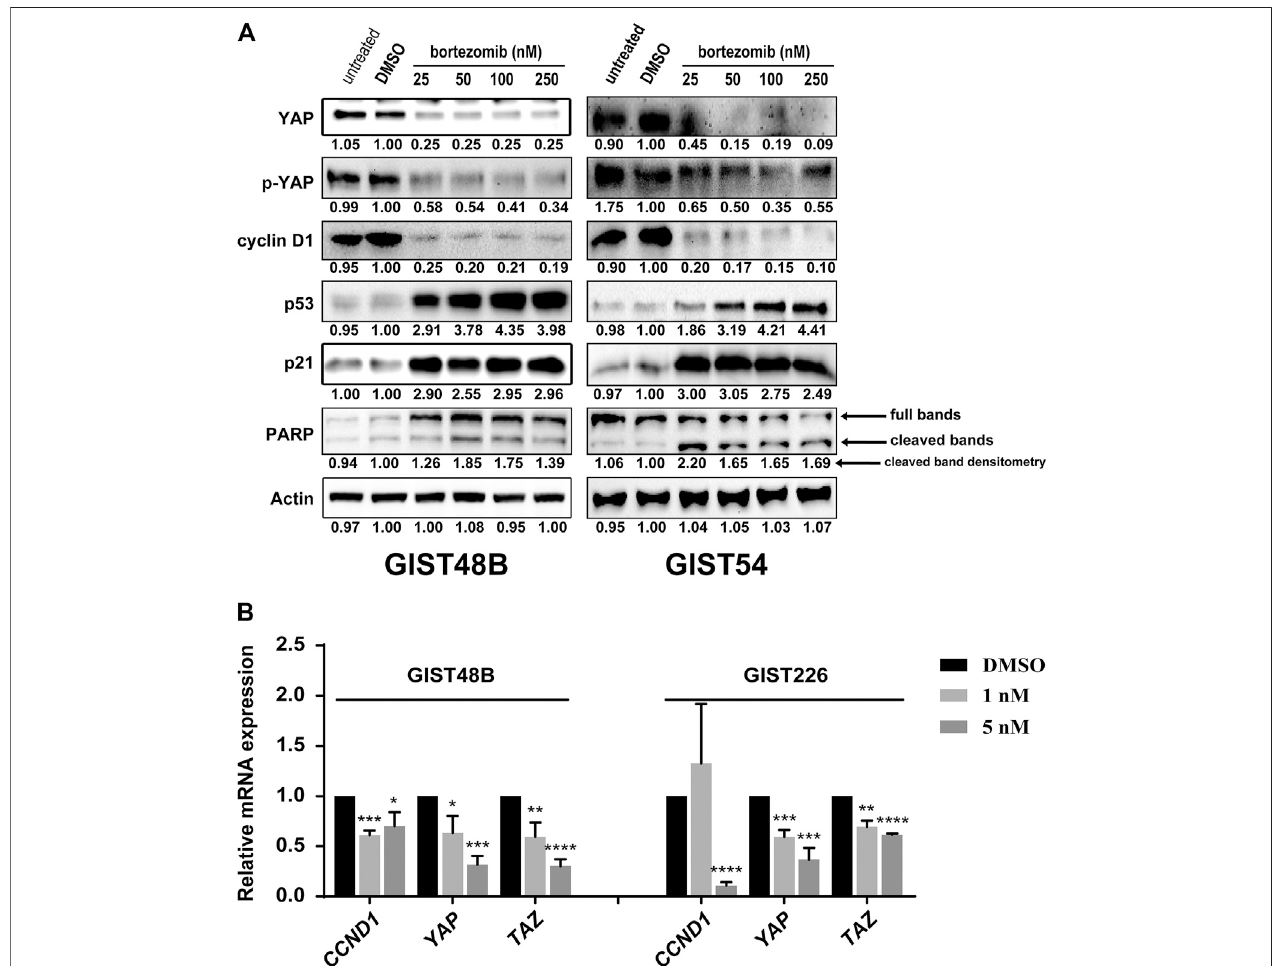
FIGURE 2 | (A) Immunoblotting evaluated expression of cyclin D1, YAP, p-YAP, p53, p21, and pro-apoptotic marker PARP in KIT-independent GIST cell lines (GIST48B and GIST54) after treatment with bortezomib for 72 h. Actin stain is a loading control. Linear capture quantitation of immunoblotting chemiluminescence signals,usinganImageQuantLAS4000.IntensityvaluesarestandardizedtotheDMSOcontrol. (B) QuantitativeRT-PCRevaluationsof CCND1 , YAP ,and TAZ transcript expression in GIST48B and GIST226 after treatment with bortezomib for 24 h. Data were normalized to DMSO control and represent the mean values ( ± s.d.) from triplicate assays, and were averaged from two independent experiments. Statistically signi fi cant differences between DMSO control and bortezomib treatment are presented as * p < 0.05, ** p < 0.01, *** p < 0.001, **** p < 0.0001.